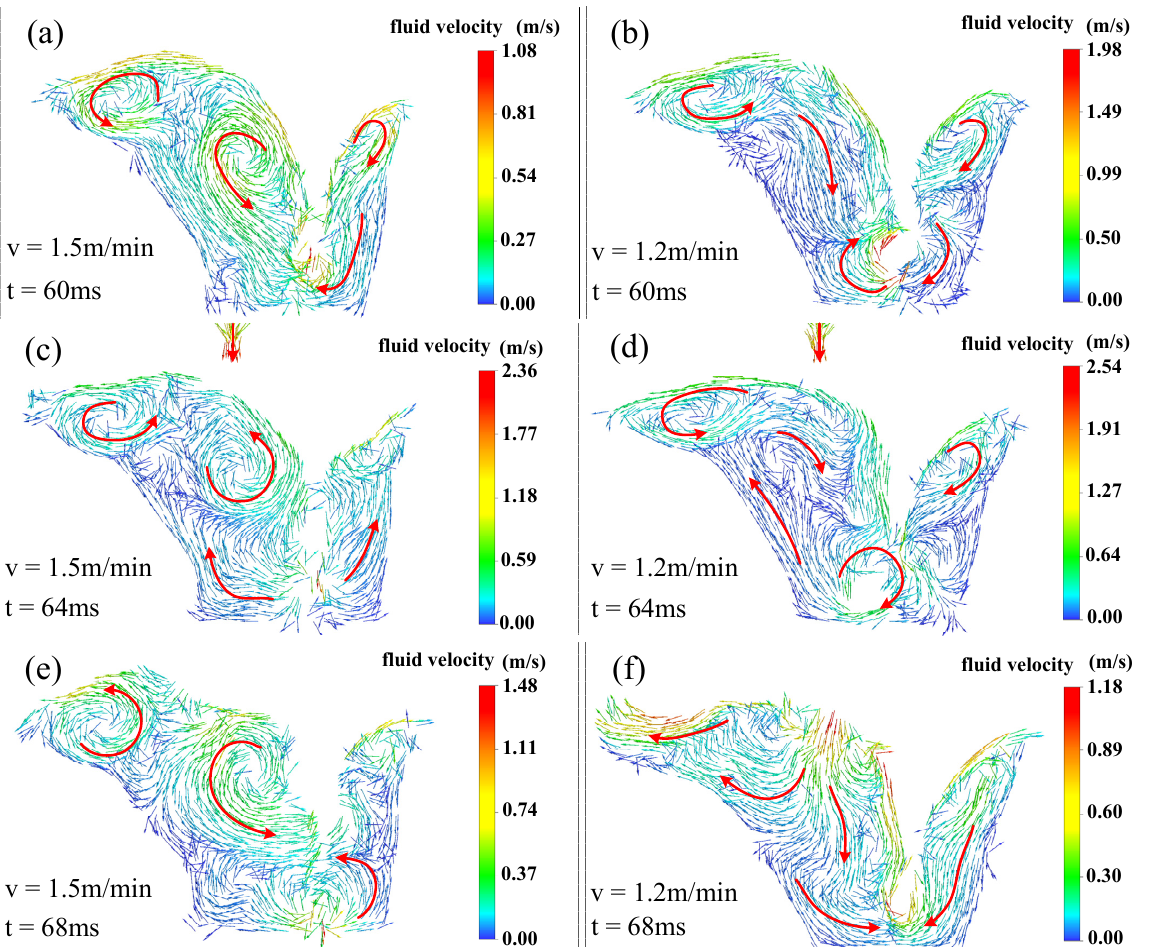
Figure 11. Simulation results of fluid flow during keyhole evolution process under different welding speed. ( a , c , e ) v = 1.5 m/min; ( b , d , f ) v = 1.2 m/min.